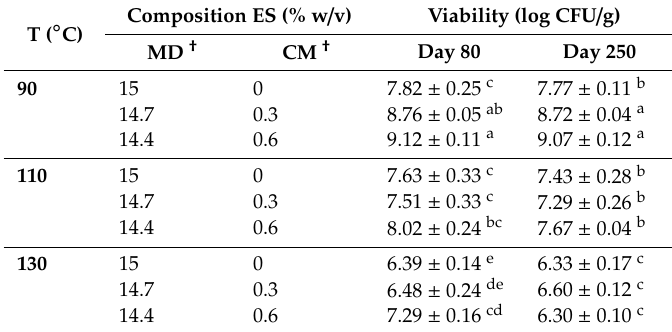
Table 4. E ff ect of the encapsulating solution (ES) composition and drying inlet air temperature (T) in spray drying on viability of L. rhamnosus after 80 and 250 days of storage at 4 ◦